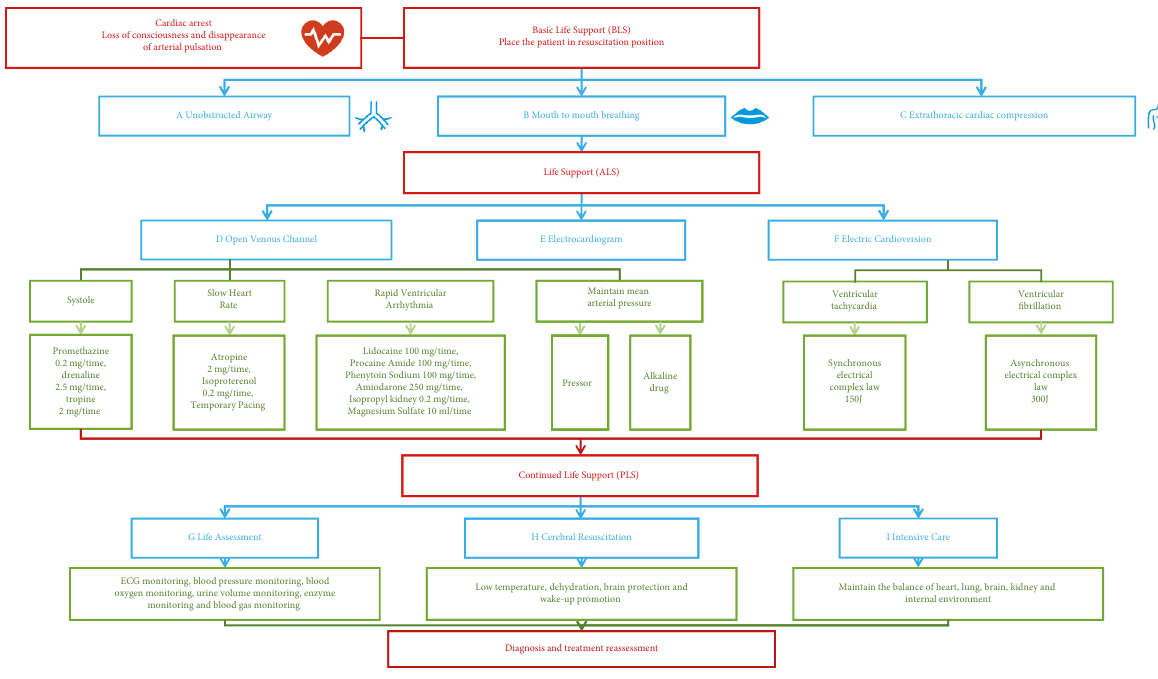
Figure 1: Flow chart of cardiorespiratory endurance